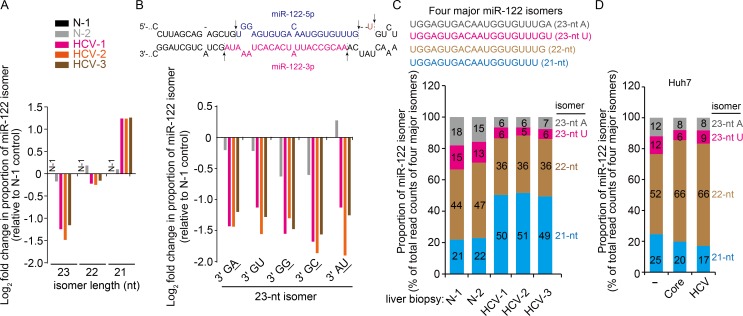
Non-templated nucleotide addition to the 3′ end of miR-122 is suppressed in liver tissue from patients with HCV and in Huh7 cells expressing HCV core protein or infected with HCV.(A) Analysis of miR-122 isomers identified by the deep sequencing of small RNA libraries from human liver biopsies. Fold change (log2) of the proportion of each miR-122 isomer (each isomer read count divided by the total count of miR-122 isomers) in the indicated specimens compared with the corresponding value in the normal liver tissue (N-1). (B) Fold-change analysis for the 23-nt isomers as described in (A). Isomers are sorted according to their 3′-end dinucleotide sequences. Presented at the top is the pri-miR-122 sequence showing processing sites (blue arrows) for the 22-nt prototype miR-122 and an aberrant 3′-terminal processing site (black arrow) for the 23-nt isomer bearing a template-derived 3′ GU-tail. (C) Proportions (% of each isomer read count compared with the total read counts of the four major isomers shown at the top) of four major miR-122 isomers (isomers whose relative percentage to the total read counts of miR-122 isomers is >2%) in the indicated liver biopsies. (D) Proportions of four major miR-122 isomers in Huh7 cells transiently expressing HCV core protein (Core) or infected with HCV.